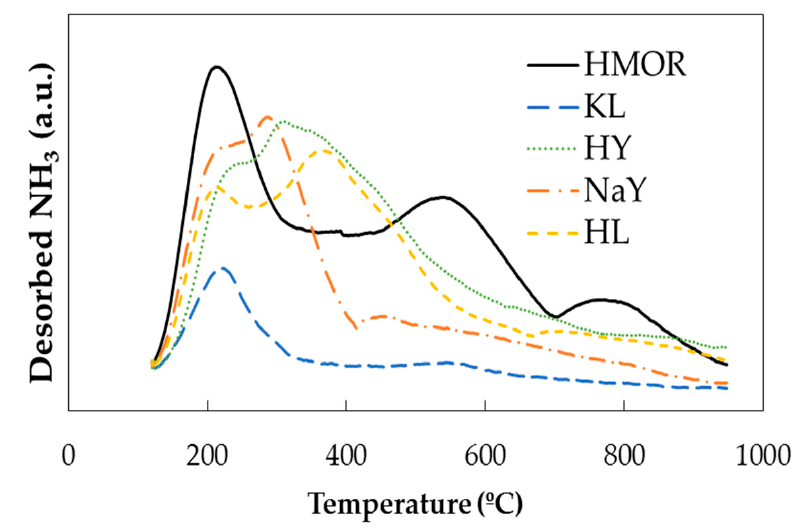
Figure 4. NH 3 -TPD curves of the catalysts.